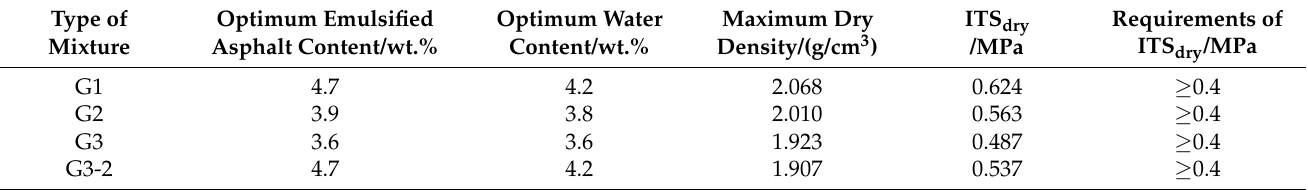
Table 6. Mix design results of